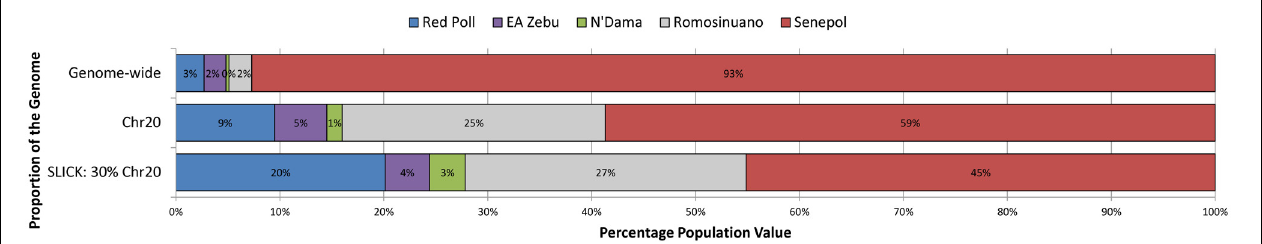
on a genome-wide level (top), using BTA20 (middle), and targeting the SLICK locus (bottom). The percentage of each genetic breed signature is denoted by a different color. The Senepol generated a unique signature denoted in red, with blue representing Red Poll, purple being East African Zebu, green being N’Dama, and gray being